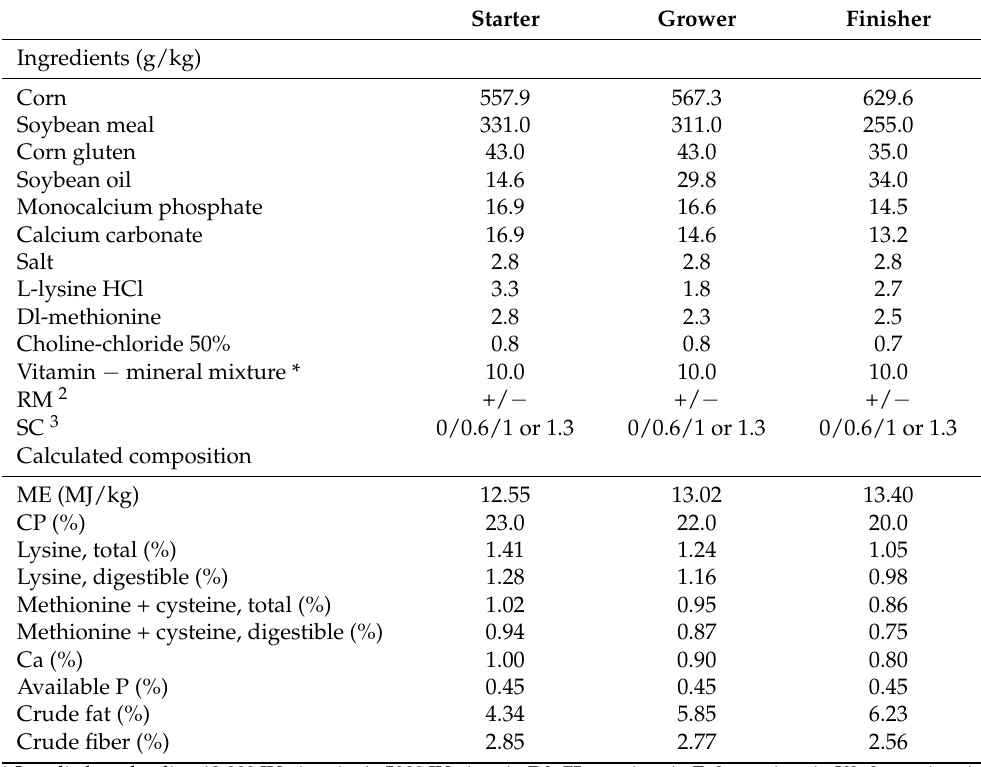
Table 2. Basal diets of broiler chicks, per each growth period 1